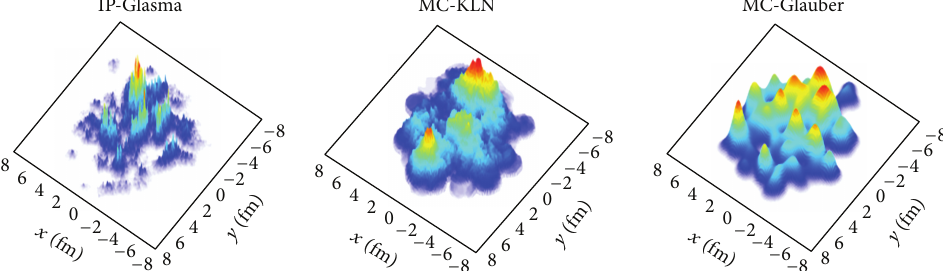
Figure 15: Initial energy density (arbitrary units) in the transverse plane in three different heavy ion collision events: from top to bottom, IP-Glasma, MC-KLN, and MC-Glauber models. The figure is from